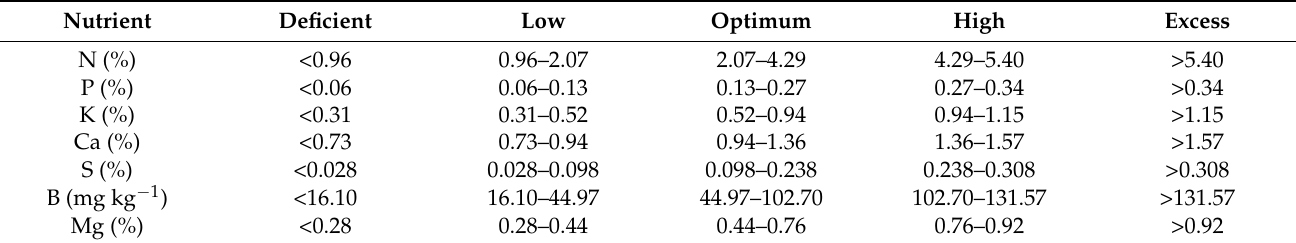
Table 4. Critical ranges of leaf